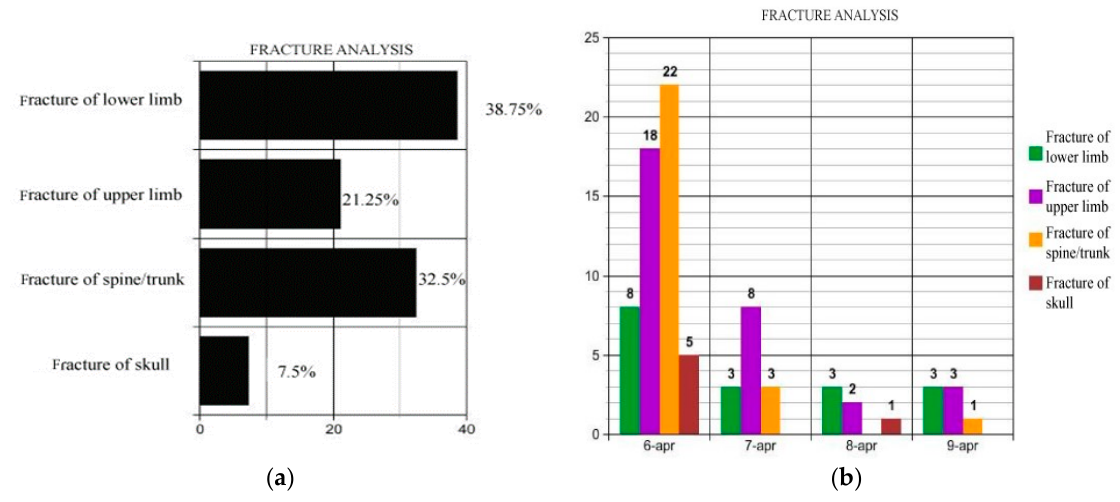
Figure 1. Fractures by anatomic site ( a ) and from 6 to 9 April ( b Figures 1. Fractures by anatomic site (N.1 a ) and from 6 to 9 April (N.1 b ).